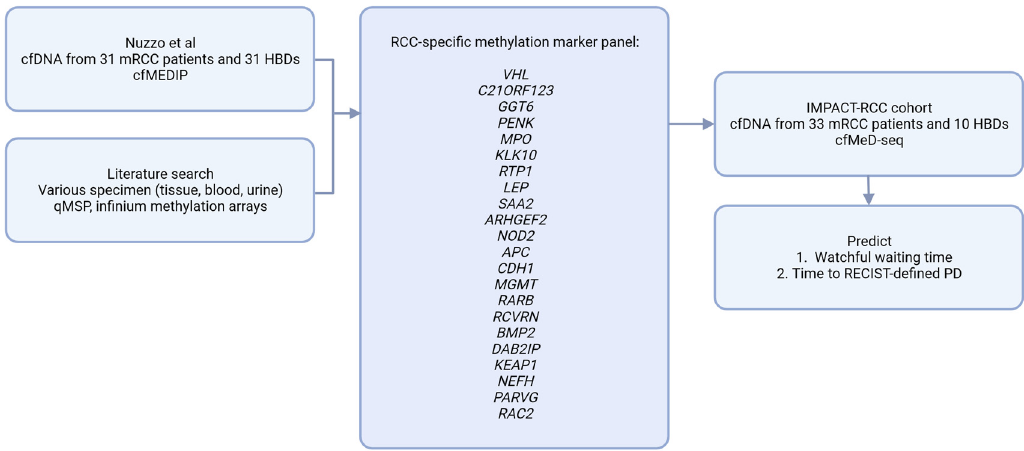
Figure 1. Analytical approach. cfMEDIP; Cell-free methylated DNA immunoprecipitation, cfMeD- seq; Methylated DNA sequencing, HBD; Healthy blood donor, PD; progressive disease, RCC; Renal cell carcinoma, qMSP; quantitative methylation specific